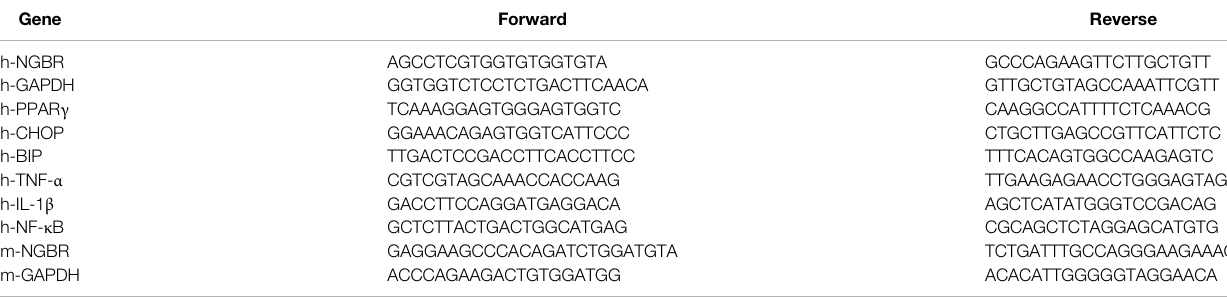
TABLE 1 | The sequences of primers for qPCR